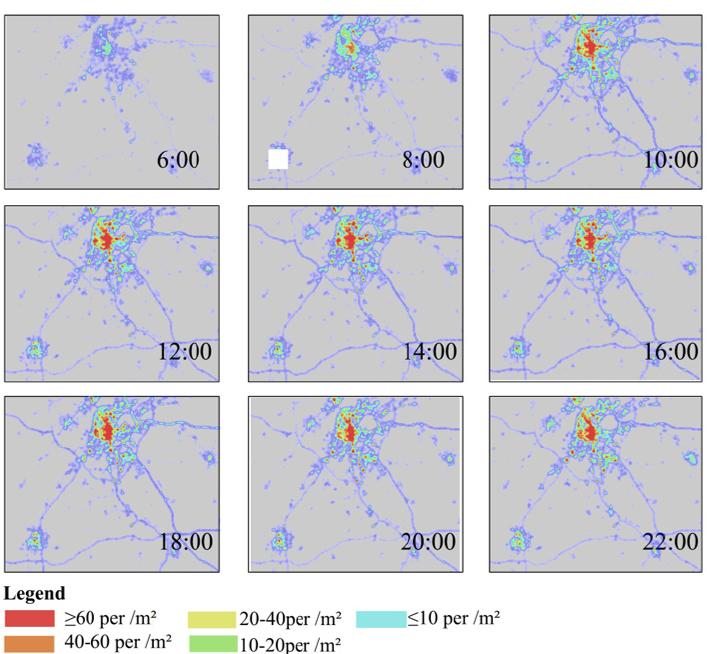
Figure 2. The population of Baidu heat map change over 24 h on September 27 (weekend).